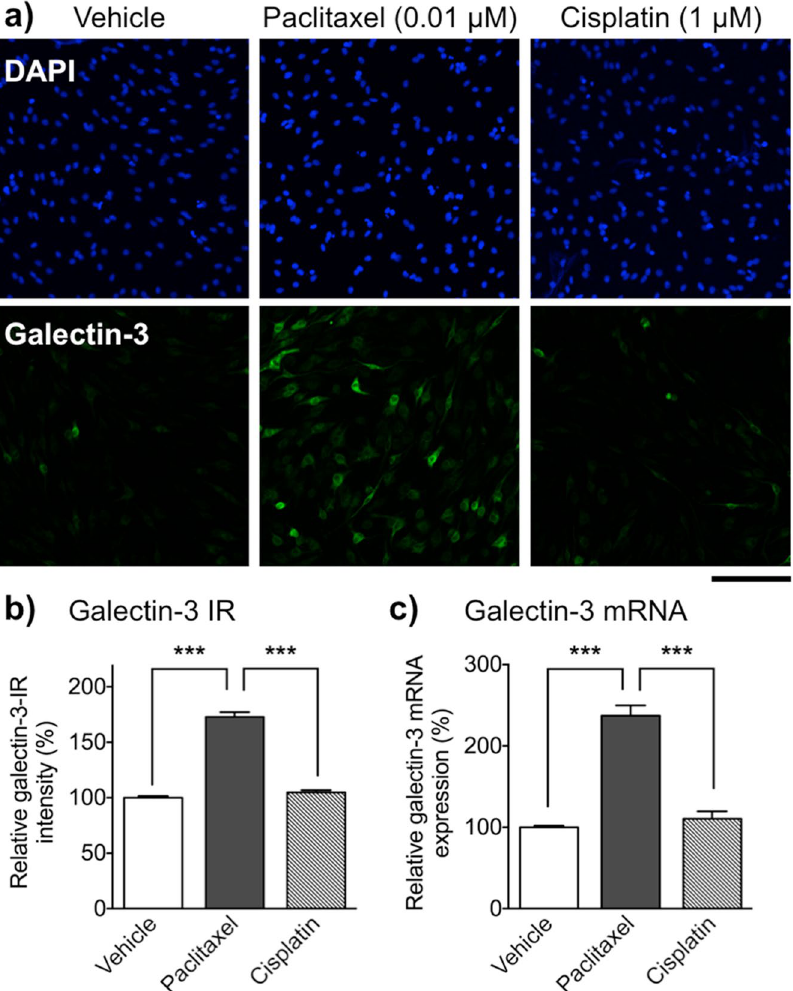
Figure 7. Effect of paclitaxel, cisplatin and oxaliplatin on expression of galectin-3 in primary cultured Schwann cells. Schwann cells were treated with vehicle (0.1% DMSO), paclitaxel (0.01 μ M) or cisplatin (1 μ M) for 48 h. ( a ) Immunofluorescence staining of primary cultured Schwann cells with DAPI (blue) and an anti- galectin-3 antibody (green). Scale bar: 100 μ m. ( b ) Galectin-3-IR in Schwann cells. Each column represents the mean ± S.E.M. n = 3. *** p < 0.001 vs . the vehicle-treated group. Only weak galectin-3-IR was observed in Schwann cells after treatment with vehicle or cisplatin, whereas paclitaxel increased galectin-3-IR in Schwann cells. ( c ) Quantitative real-time PCR analysis of galectin-3 mRNA expression in Schwann cells. Each column represents the mean ± S.E.M. n = 3. *** p < 0.001. Treatment with paclitaxel, but not cisplatin, led to a significant increase in expression of galectin-3